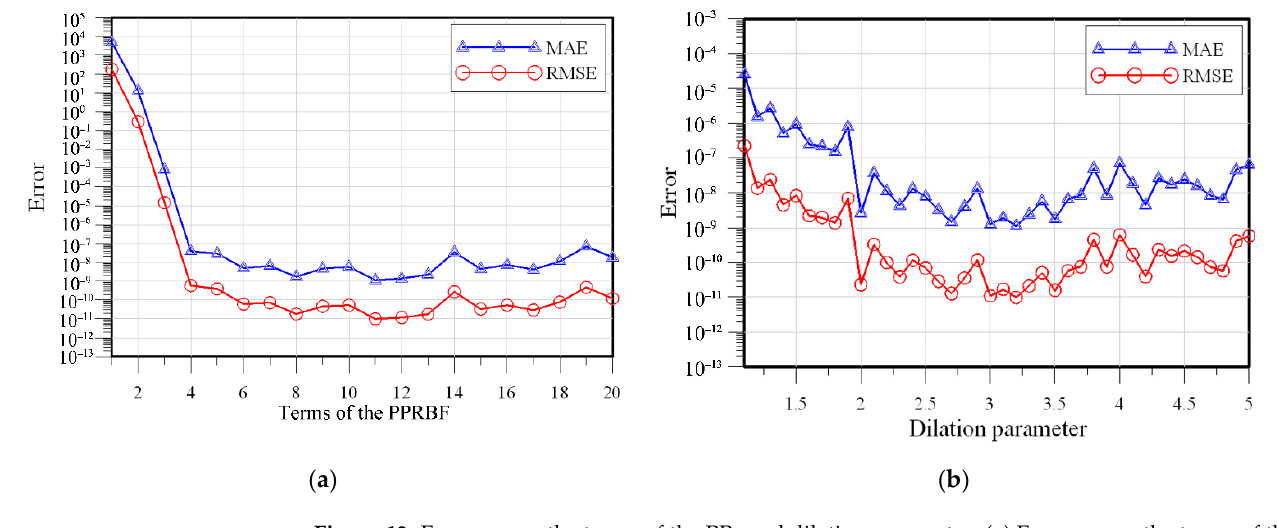
Figure 13. Error versus the terms of the PPs and dilation parameter: ( a ) Error versus the terms of the PPs for case A. ( b ) Error versus the dilation parameter for case B.